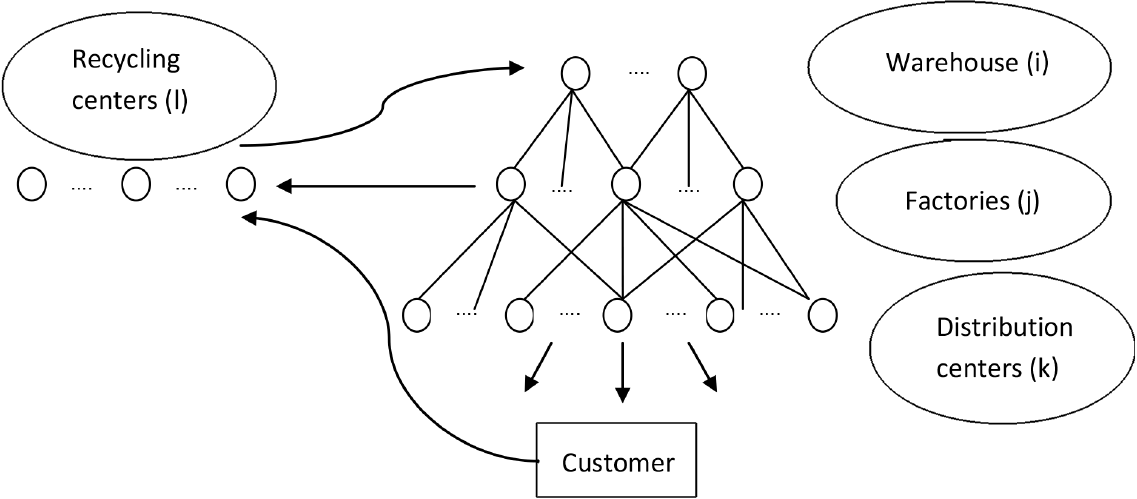
Figure 4. The general form of the given supply chain